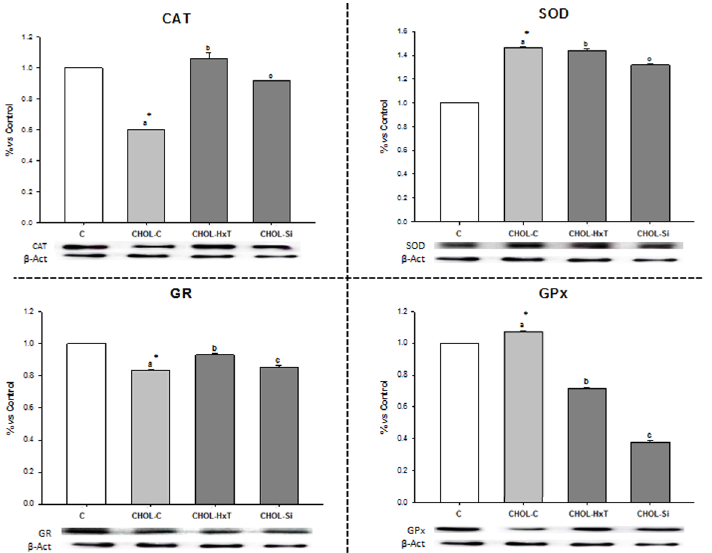
Fig 2. Effect of silicon or hydroxytyrosol-restructured pork on liver enzymatic antioxidants in aged rats fed high-saturated/high-cholesterol diets. Mean values and standard deviations (n 6). C, control diet; CHOL-C, cholesterol enriched high-saturated/high-cholesterol control diet; CHOL-HxT, hydroxytyrosol RP cholesterol enriched high-saturated/high-cholesterol diet; Si, silicon RP cholesterol enriched high-saturated/ high-cholesterol diet. Statistical comparison between C and CHOL-C diets, * indicate significant differences (at least p < 0.05). Bars with different letters indicate significant differences (at least p < 0.05) between CHOL-C, CHOL-HxT and CHOL-Si groups. CAT, catalase; SOD, superoxide dismutase; GR, glutathione reductase; GPx, glutathione peroxidase. Results were calculated as percentage relative to control.